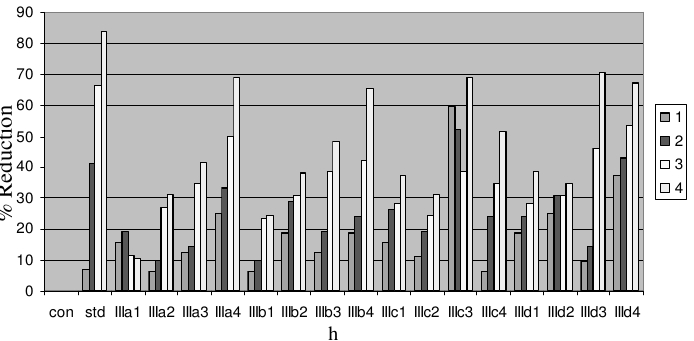
Figure 1 .Anti-inflammatory activity of quinazoline